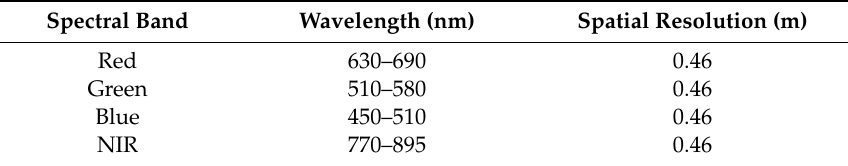
Table 1. WordView-2 band descriptions.